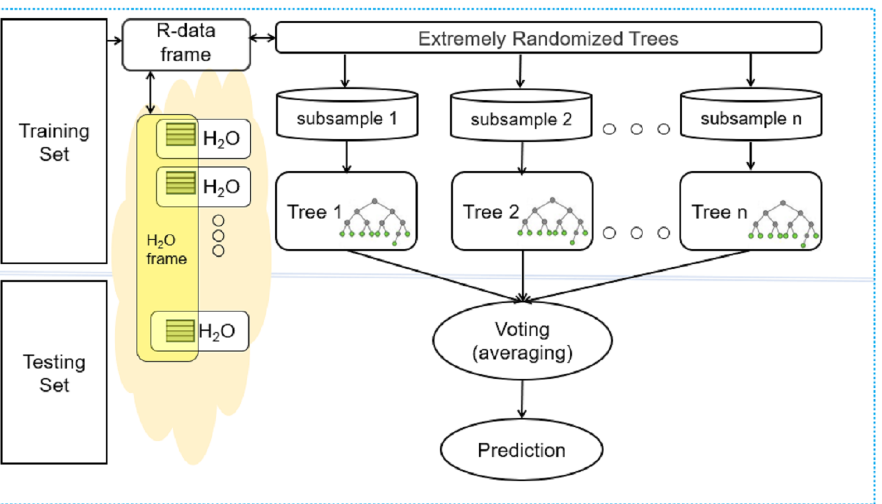
Figure 5. Distributed random forest.